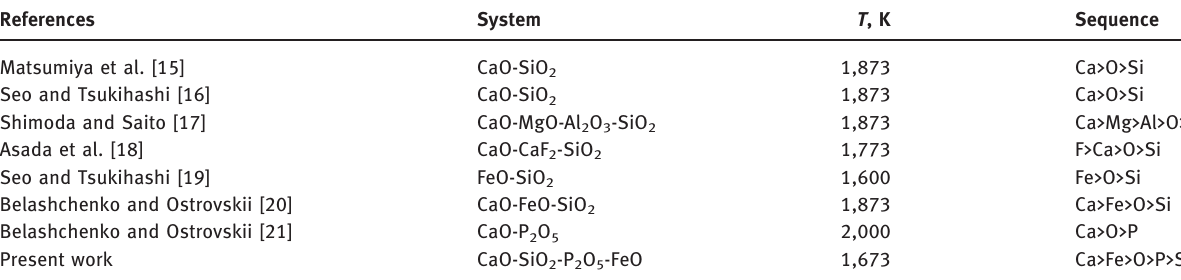
Table 3: Diffusivity sequence of ions in different molten systems.